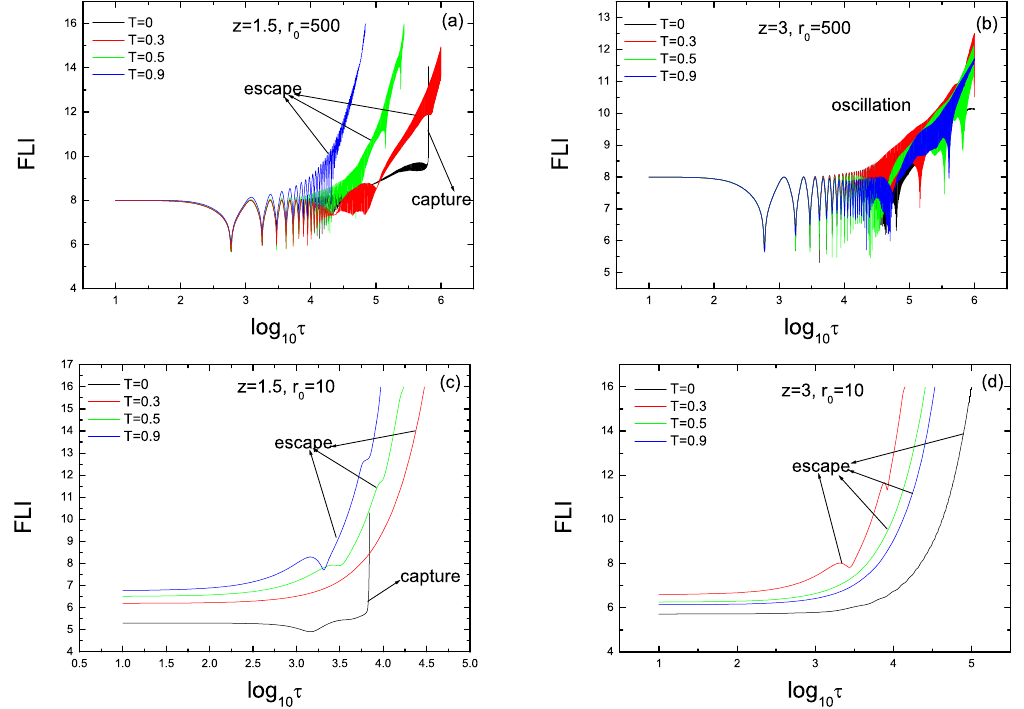
Figure 6 . FLIs with di(cid:11)erent z (left plots for z = 1 : 5 and right plots for z = 3) and T for r 0 = 500 (plots above) and r 0 = 10 (plots below) with di(cid:11)erent z . captured becomes shorter (see the above left plot in (cid:12)gure 7). Especially, we (cid:12)nd that for z = 1 : 8 the string rapidly falls into black brane without any oscillating and the oscillating time is very short once the HV exponent (cid:18) is beyond the value of (cid:18) = 0 : 1. When the initial position of the string is near the black brane, the string falls into the black brane for all allowed (cid:18) (see the above right plot in (cid:12)gure 7). With the increase of (cid:18) , the falling velocity becomes faster. Then we focus the case of z > 2. When the initial position of the string locates far away from the black brane, with the increase of (cid:18) , the string changes from the state of oscillating at the last stage to the state of captured by the black brane (see the left below plot in (cid:12)gure 7). When the initial position of the string is near the black